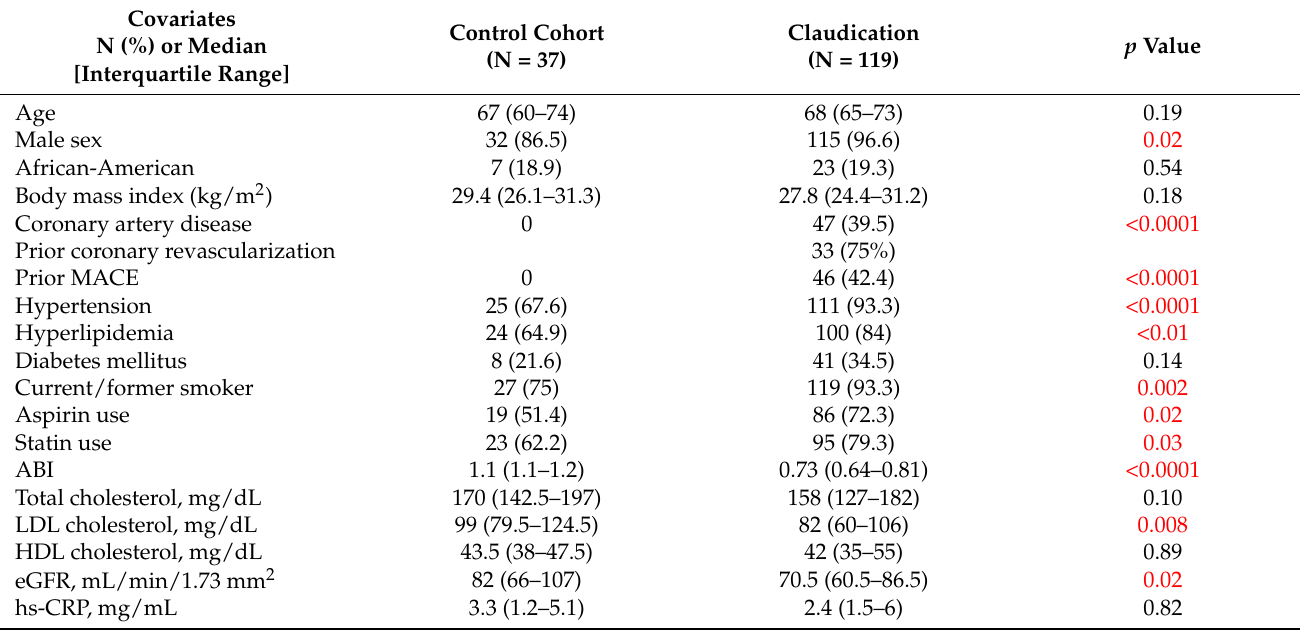
Table 1. Baseline characteristics of study